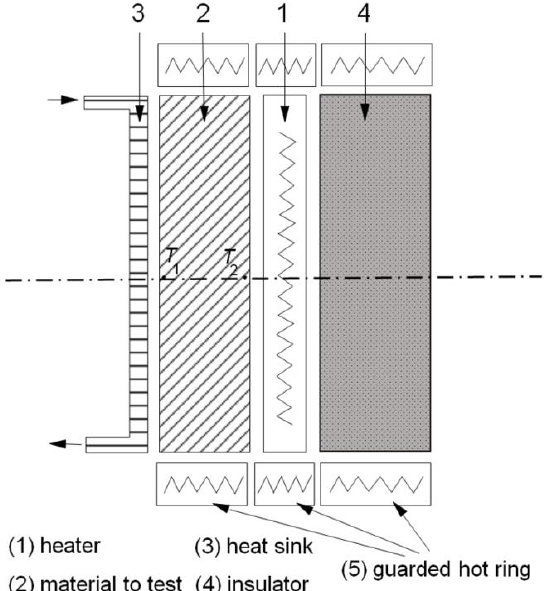
Figure 1. Sketch of the guarded hot ring system used to measure thermal conductivity.